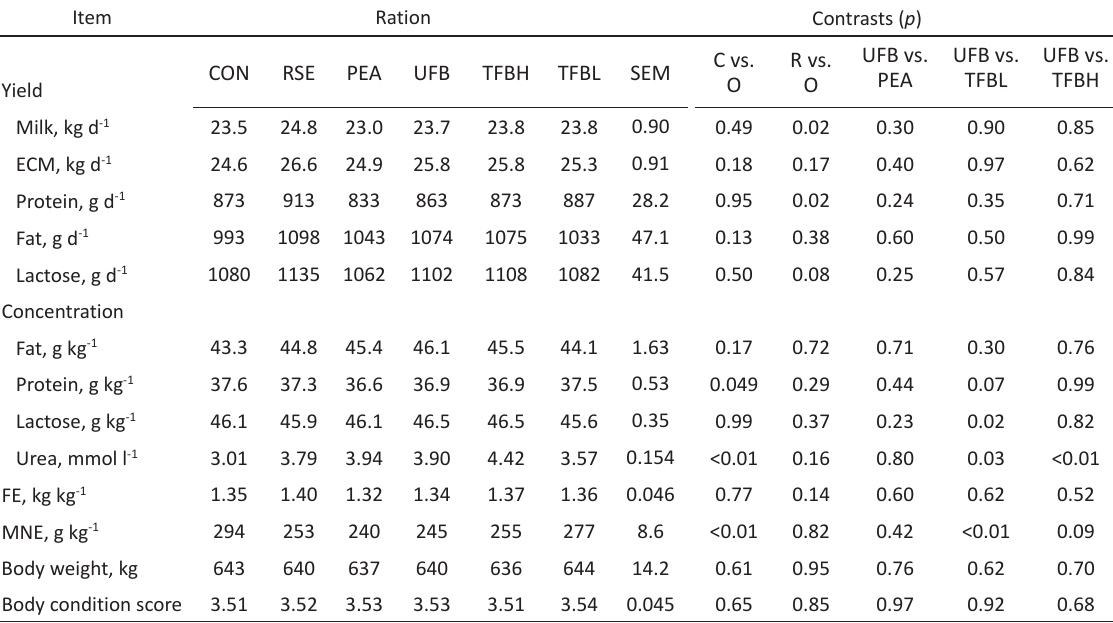
Nutrient intake and milk production Protein supplementation had no effect ( p =0.13) on DM intake, however CP intake was greater ( p <0.01) for the protein feeds compared to the control diet without any protein supplement (Table 3). The RSE protein supple- mented diet showed greater estimates of amino acid (AAT) intake ( p <0.01) compared to other diets excluding the control diet (Table 3). Heat-treated FB had no effect on DMI, milk or protein yield compared to UFB. Milk yield or ECM yield, were not significantly different for the control diet compared to the protein supplemented diets (Table 4). This was mainly because peas or FB supplemented diets did not increase milk and protein yield compared to the control diet. The RSE protein supplemented treatment increased milk (24.8 vs. 23.6 kg d -1 ) and protein yield (913 vs. 863 g d -1 ) compared to other protein supplements (Table 4). Milk nitrogen efficiency decreased and milk urea increased with protein supplementation compared to the control diet (254 vs . 294 g kg -1 and 3.01 vs . 3.92 mmol l -1 , respectively) as shown in Table 4. Table 4. Mean treatment effects on milk production and nitrogen efficiency between diets Item Ration Contrasts ( p ) UFB vs. UFB vs. UFB vs. C vs. R vs. CON RSE PEA UFB TFBH TFBL SEM PEA TFBL TFBH O O Yield Milk, kg d -1 23.5 ECM, kg d -1 Protein, g d -1 873 Fat, g d